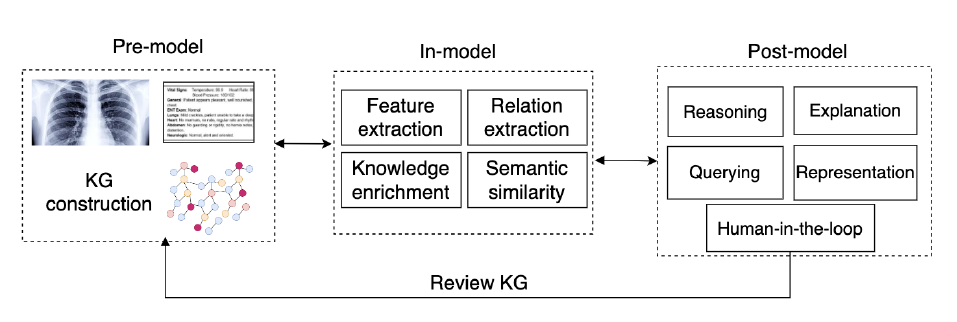
Figure 1. The figure shows how an XAI model can use knowledge graphs for explainability. On the other side, XAI methods can be used to discover new knowledge from knowl- edge graphs by grouping nodes, link prediction or node classification [56]. Graph repre- sentation learning [57] approaches, as an example, can be used in healthcare to encode the network structure into low-dimensional space of dense vectors that often are assigned to nodes [58], but can also embed edges